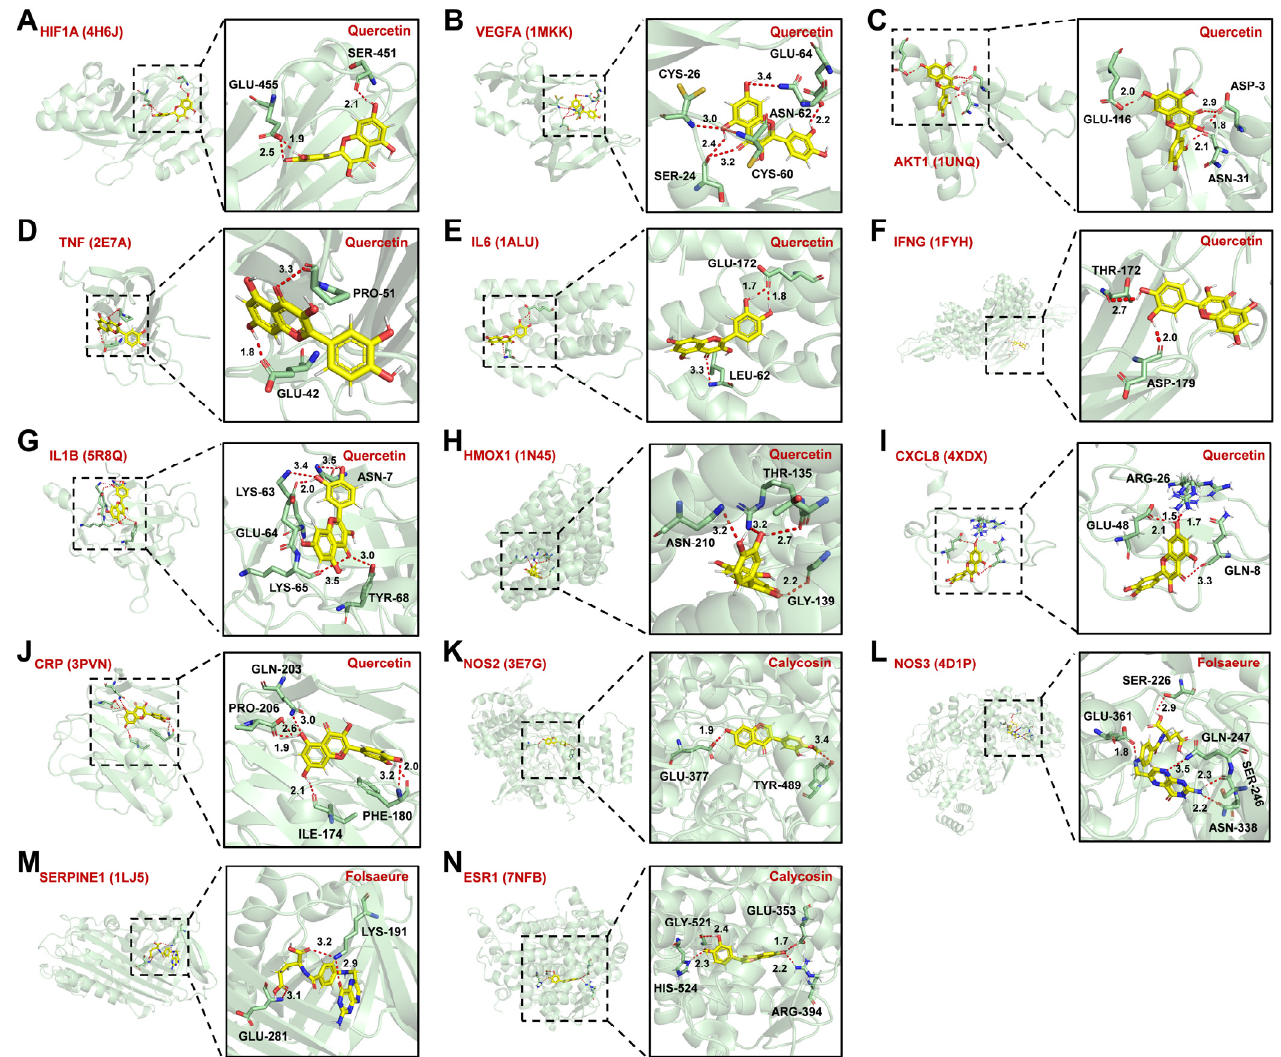
Figure 7. Molecular docking of core targets with active components. ( A – J ) Molecular docking pattern of quercetin with HIF1A ( A ), VEGFA ( B ), AKT1 ( C ), TNF ( D ), IL6 ( E ), IFNG ( F ), IL1B ( G ), HMOX1 ( H ), CXCL8 ( I ), and CRP ( J ). ( L , M ) Molecular docking pattern diagram of folsaeure with NOS3 ( L ) and SERPINE ( M ). ( K , N ) Molecular docking pattern of calycosin with NOS2 ( K ) and ESR1 ( N ). The 3D structures of core targets were from the PDB database with the corresponding PDB ID listed in parentheses after the target name. Molecules were anchored into the active pocket by binding to amino acid residues of the core target. Intermolecular hydrogen bonds were displayed as red dashed lines with bond lengths annotated next to them in angstroms.